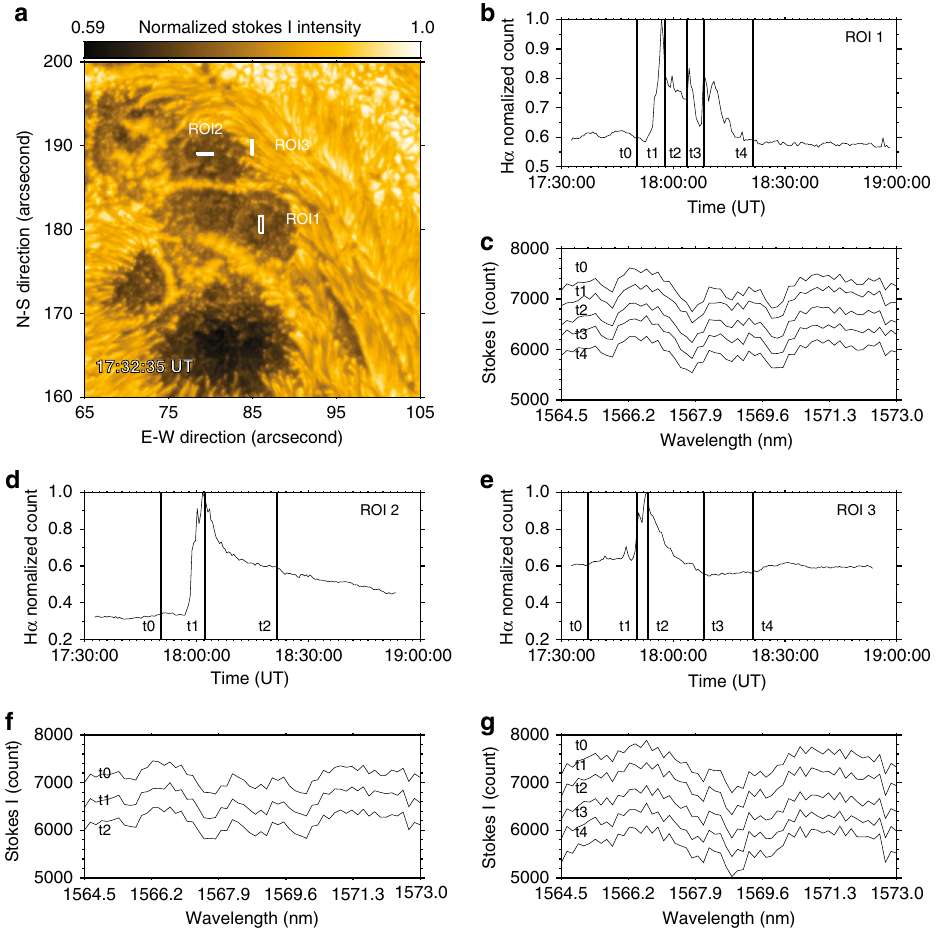
Fig. 4 Intensity pro fi les of the NIR line at 1.56m during the fl are a Stokes I component taken at 17:32:35 UT. The intensity is normalized to the maximum count, as shown in the color bar. Three representative areas are marked using white boxes (ROI1, ROI2, and ROI3). b H α light curve in ROI 1. The vertical lines indicates fi ve time points before, during, and after the fl are. The corresponding NIR intensity pro fi les (Stokes I) are plotted in ( c ), from which we see almost identical line pro fi les indicating that the fl are heating almost has no effect in this deep layer of solar atmosphere. d H α light curve in ROI 2. The corresponding NIR intensity pro fi les at t0, t1, and t2, are plotted in ( f ). e H α light curve in ROI 3. The corresponding NIR intensity pro fi les at t0-t4 are plotted in ( g 1.56 μ m. Other panels show the SDO/HMI white-light image in Fig. 1a, a running difference image of H α blue wing ( − 1.0 Å) in Fig. 1b, and LOS magnetogram derived from NIRIS data in Fig. 1c. All the images are within the same FOV, where the ribbon of interest resides. To examine the azimuth change, we resolved the 180° azimuthal ambiguity in the transverse fi eld using the minimum-energy method 26 , and removed the projection effects by transforming the vector magnetogram from observational image plane to heliographic-cartesian coordinate. Figure 1e pre- sents a time – distance diagram of the running difference H α images. The slit is 3-pixel wide and its position can be found in Fig. 1b. The bright feature represents the ribbon front of H α emission, similar to the one in Fig. 1b. In Fig. 1f, we display the time – distance diagram of running difference images of the azi- muth angle. The slit width is 9 pixels, because the cadence of the vector magnetogram is 90 s, which is about 3 times of the cadence of H α images. The white contour indicates the location of H α ribbons in Fig. 1e. It shows a good correlation between H α emission and azimuth-angle change at different times. Such a correlation does not vary much at different slit positions. The characteristic sizes of ribbon-like features are fundamental parameters. For instance, the ribbon front, which is the precipitation site of electrons, is found to be very narrow 27,28 .